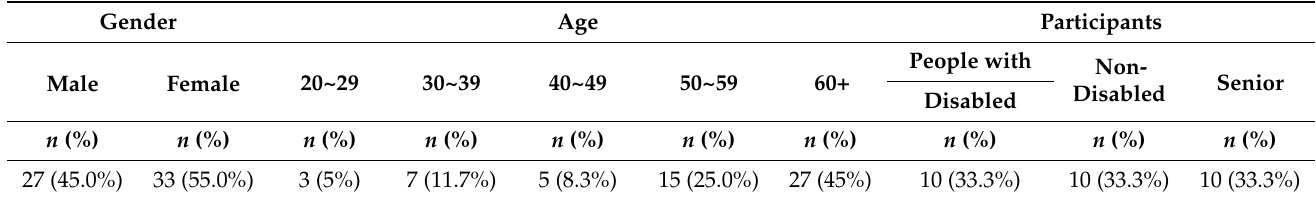
Table 4. Characteristics of 3D design satisfaction assessment